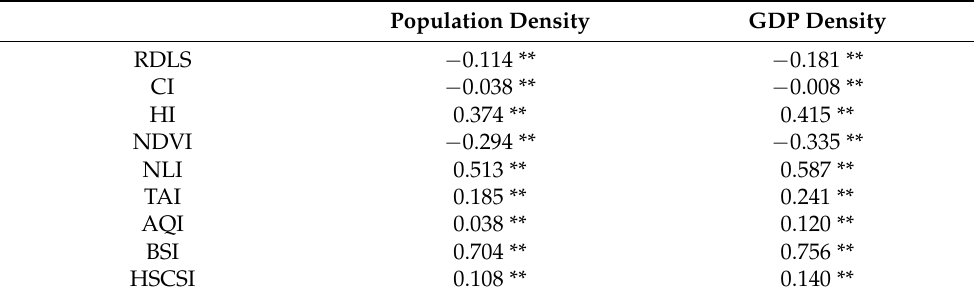
Figure 7. Spatial distribution of population and GDP density in the YRD. Table 5. Correlation coefficients between human settlement suitability factors and population and GDP density in the